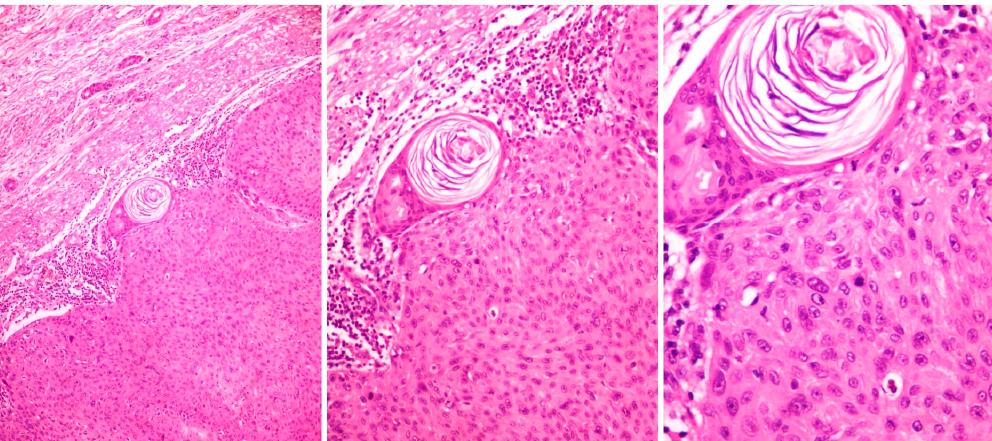
Figure 3. Histopathological picture of eccrine porocarcinoma exhibiting poromatous basaloid epithelial cells and duct formation (hematoxylin and eosin staining, 40×, 100×, 200×).